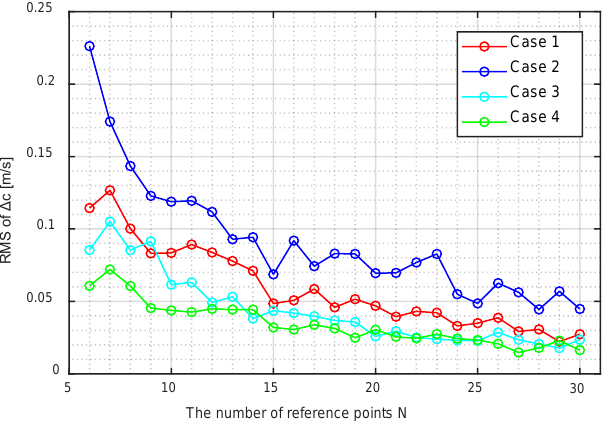
Remote Sens. 2021 , 13 , x FOR PEER REVIEW Figure 11. Convergence of the estimated wave celerity with the number of reference points.